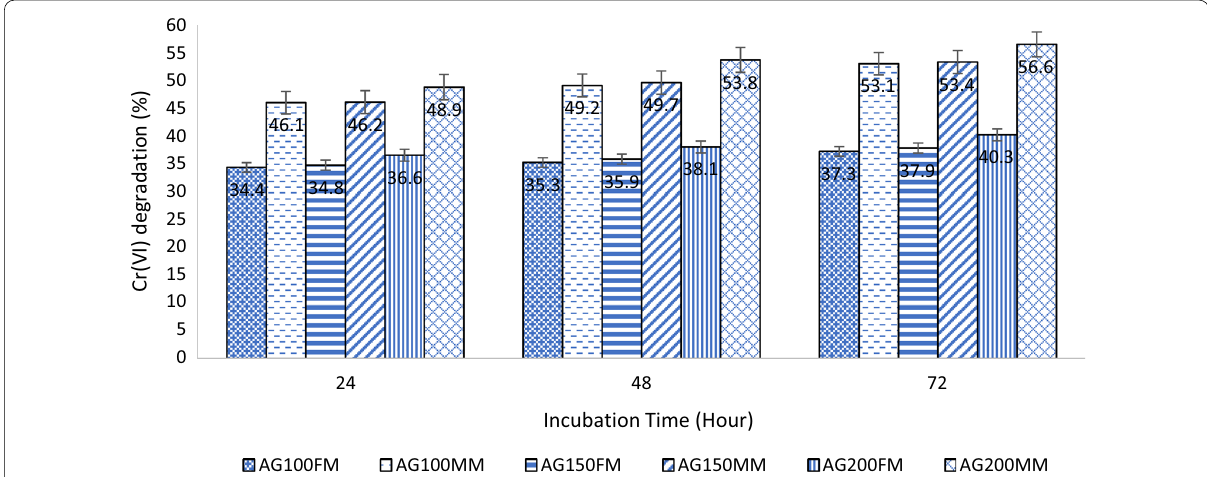
Fig. 3 Comparing chromium(VI) reducing the efficiency of fresh media (FM) and modified media (MM) with different agitation (AG) speeds (100, 150 and 200 rpm) and at the constant aeration rate of 1.0 vvm